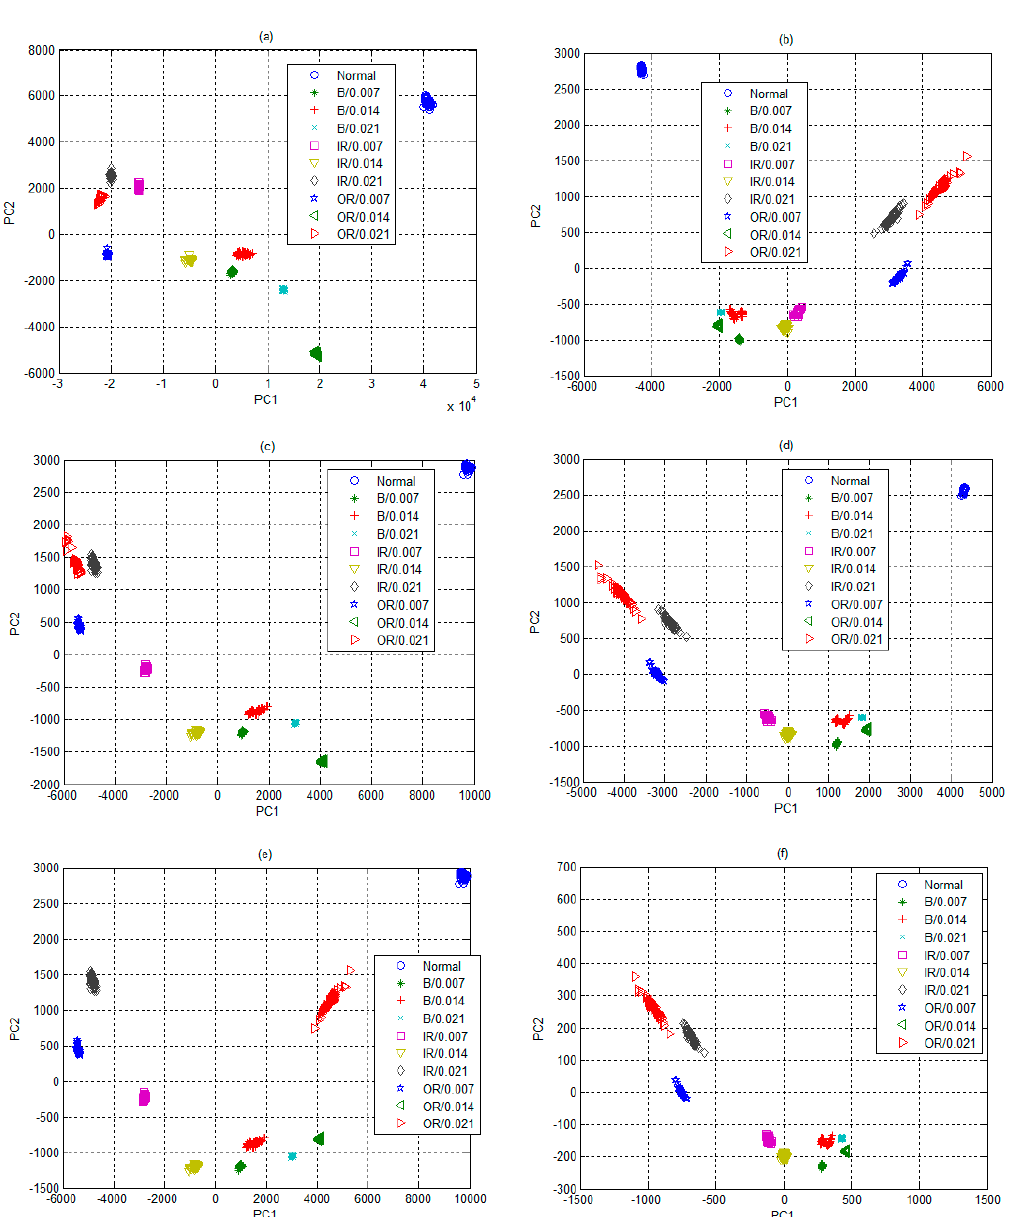
Figure 5. Experiment data for Case I of six kinds of KPCA result feature matrix: ( a ) WW 1 H ; ( b ) WP 1 ; ( c ) WD 1 ; ( d ) WI 1 ; ( e ) WL 1 ; ( f ) C 1